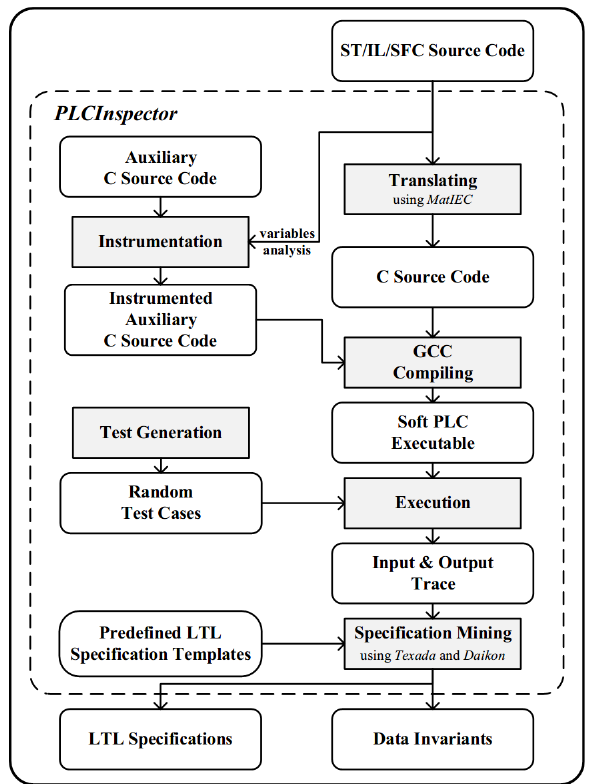
Figure 3. The implementation for the user-friendly PLC verification